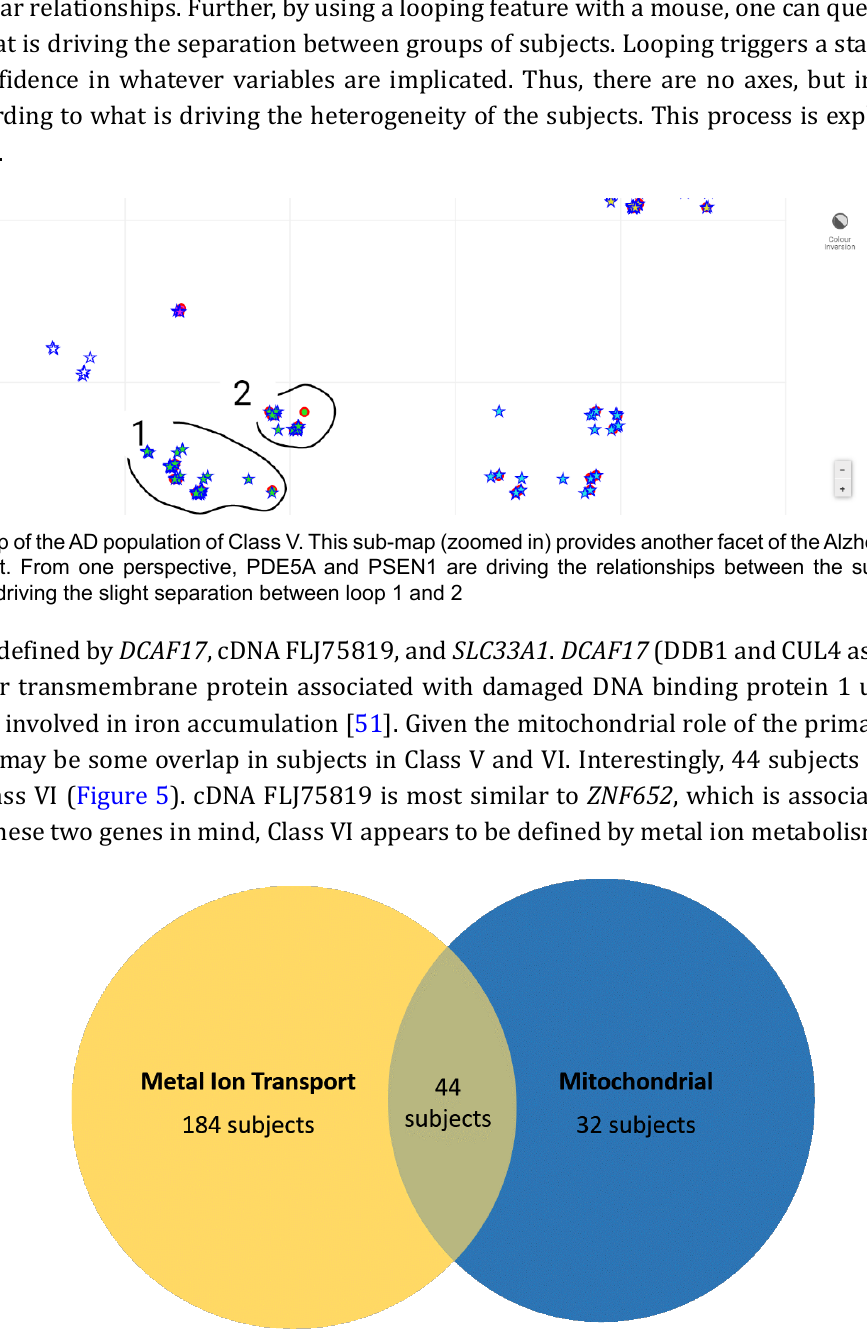
Figure 5. Overlap of subjects in the metal ion transport and mitochondrial perspective classes. A complete list of the AD samples from the data we used, in addition to which classes they fall in, is available in the supplementary materials